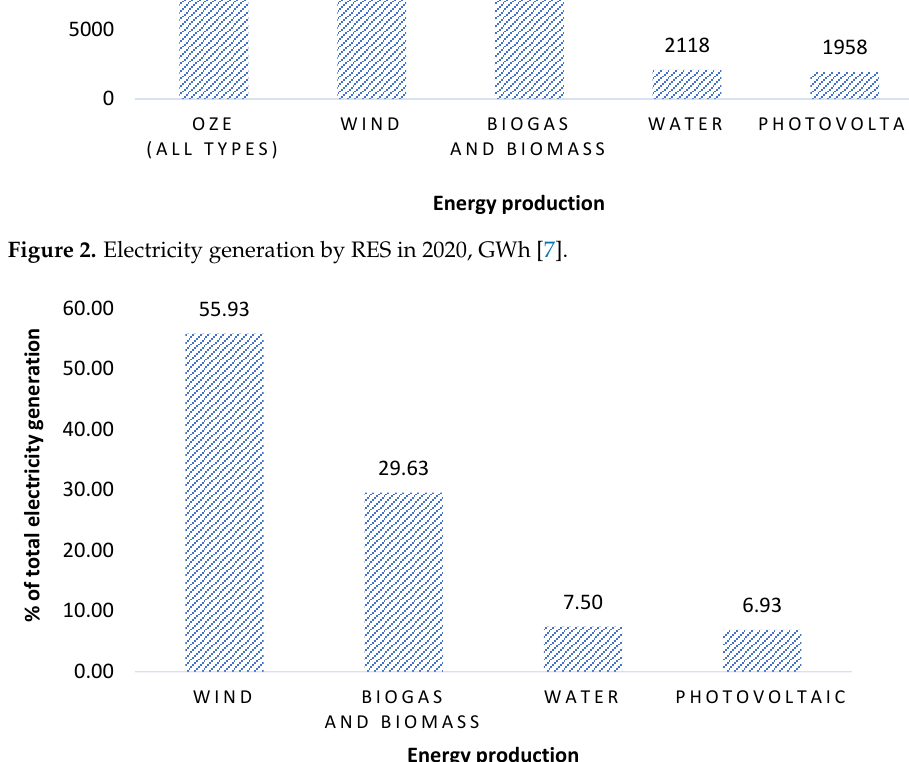
Figure 3. Electricity generation by RES, % [7].